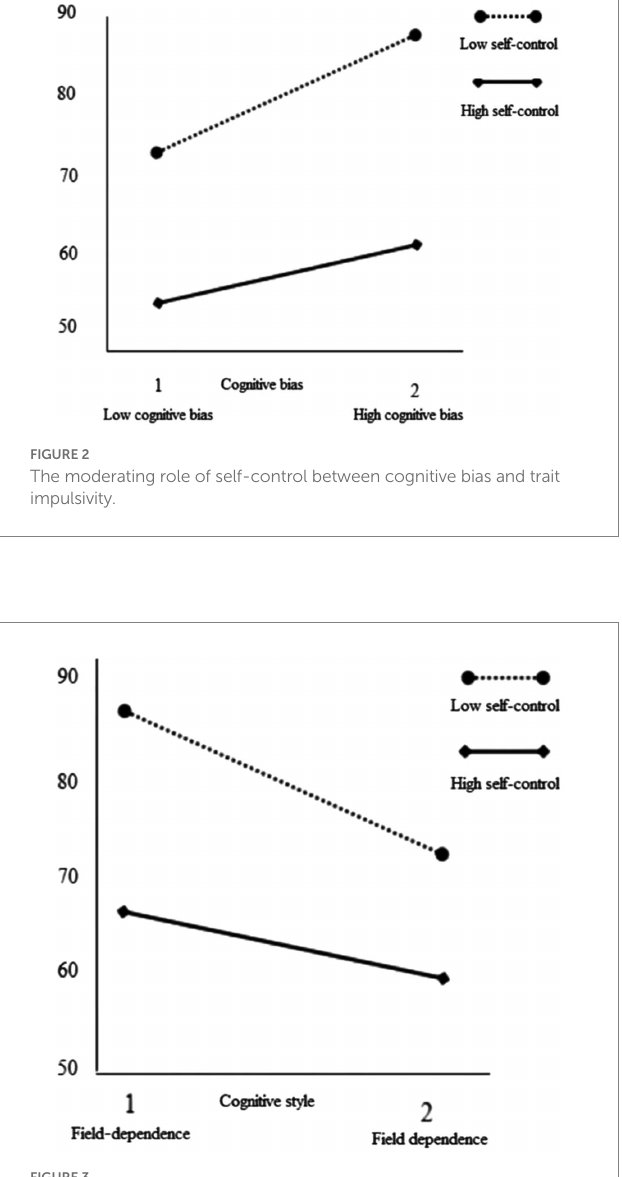
FIGURE 3 The moderating role of self-control between cognitive style and trait impulsivity.